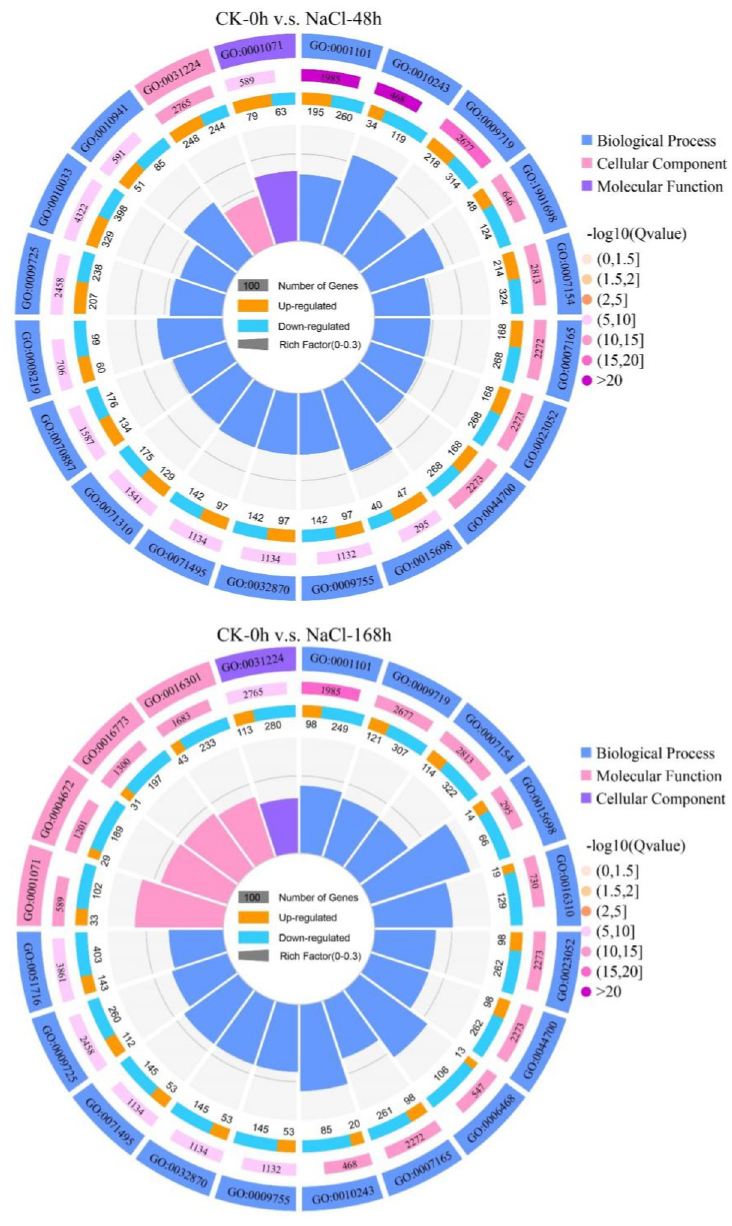
Fig 5. GO enrichment analysis of DEGs. (The first and outer circle: the top 20 GO terms are enriched, outside the circle is the scale of the number of genes. Different colors represent different Ontologies. The second circle: the number of the GO term in the background gene and the Q value. The more genes, the better the bars. Long, the smaller the Q value, the darker the color. The third circle: the bar graph of the ratio of up-regulated genes, the dark color represents the proportion of up-regulated genes, and the light color represents the proportion of down-regulated genes. The specific value is displayed below. The fourth and inner circle: the ratio of each GO term Rich Factor value (number of differential genes in this GO term divided by all numbers), background grid lines, each grid represents 0.1).